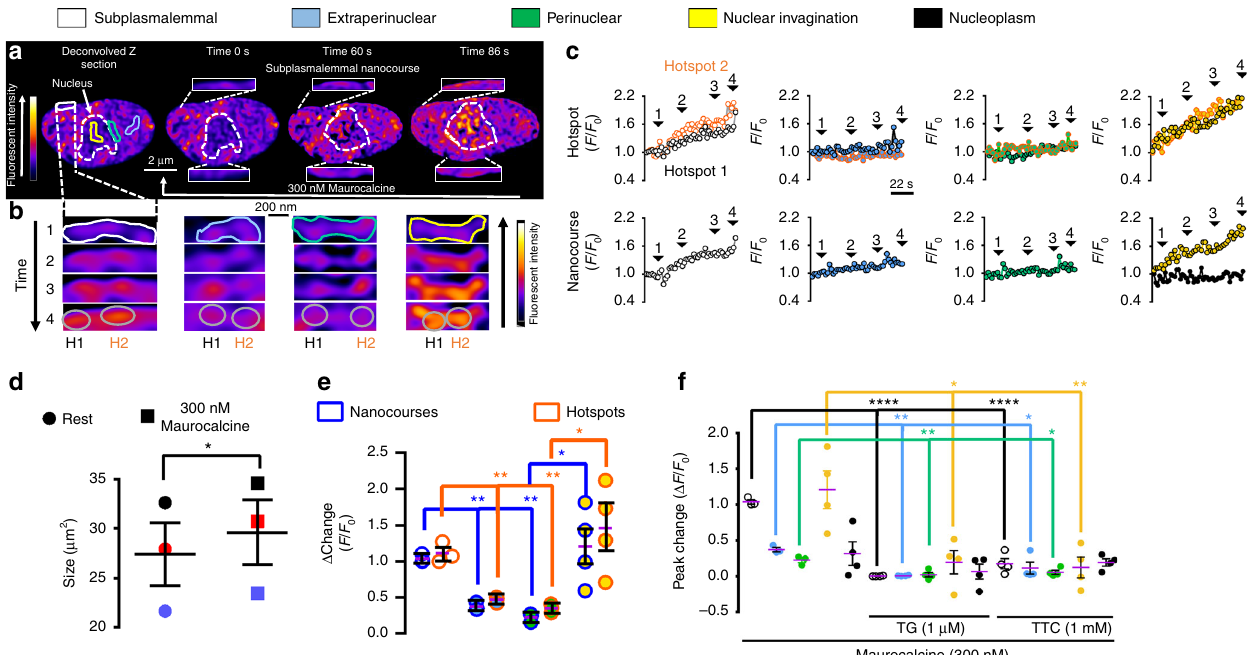
Fig. 3 Maurocalcine gates Ca 2 + fl ux into subplasmalemmal nanocourses and nuclear invaginations. a (upper panels) Deconvolved confocal images show pseudocolour representations of Fluo-4 fl uorescence intensity in z sections through an acutely isolated arterial myocyte (white broken line identi fi es nucleus) before and during application of 300 nM Maurocalcine (white arrow). White boxes inset show example subplasmalemmal nanocourses at higher magni fi cation. b From left to right, high magni fi cation examples of subplasmalemmal (white), extraperinuclear (blue), perinuclear (green) and nuclear (yellow) nanocourses identi fi ed by regions of interest in ( a ), at three different time points. Grey circles identify for each nanocourse, two hotspots (H1, black; H2, orange) of Ca 2 + fl ux. c Fluo-4 fl uorescence ratio ( F x / F 0 ; where F 0 = fl uorescence at time 0 and F x = fl uorescence at time = x) versus time (sampling frequency = 0.5 Hz) for H1 and H2 of each nanocourse (upper panels, from left to right) compared to the average for the whole nanocourse (lower panels, from left to right). d Dot plot shows cell area ( µ m 2 ; mean ± SEM) before and after extracellular application of 300 nM Maurocalcine ( n = 3 cells from 3 rats). e Dot plot shows peak change ( Δ F x / F 0 ; mean ± SEM; n = 3 cells from 3 rats) for Fluo-4 intensity for hotspots and nanocourses within each region of interest at the peak of the response to Maurocalcine (300 nM). f As for ( e ) but for whole nanocourses in the absence and presence of thapsigargin (1 µ M, 30 min pre-incubation; n = 4 cells from 3 rats) or tetracaine (1 mM; 4 h pre-incubation; n = 4 cells from 4 rats); t -test with Welch ’ s correction: * p < 0.05, ** p < 0.01, *** p < 0.001, **** p < 0.0001. The pseudocolour look up tables in ( a ) and ( b ) indicate relative fl uorescence intensity